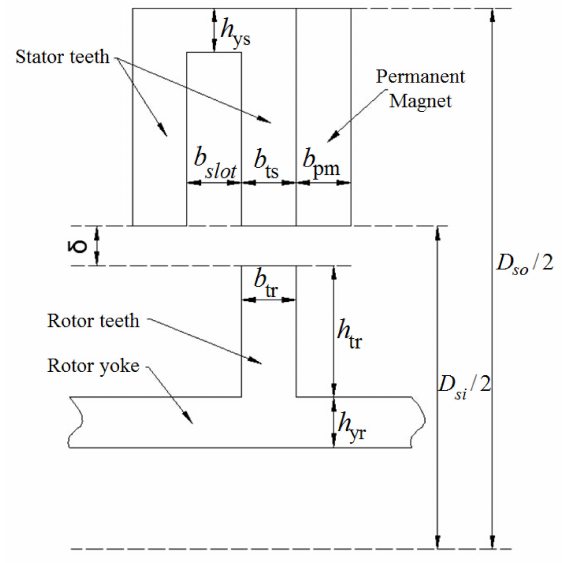
Figure 3. Dimension parameters of the FSPM